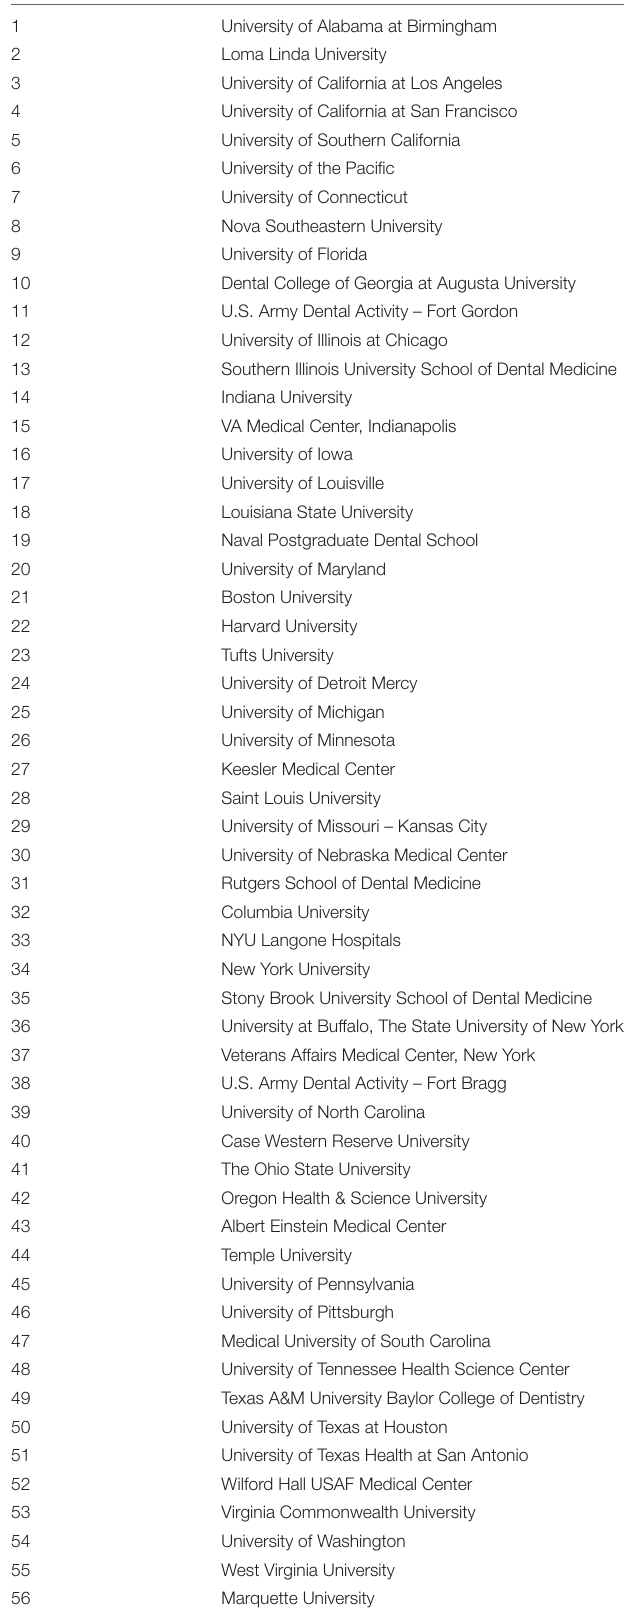
TABLE 1 | Postgraduate endodontic programs in the United